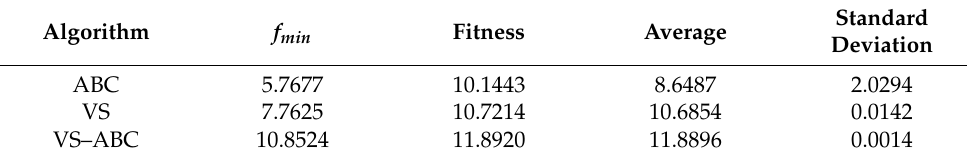
Table 15. The numerical results of